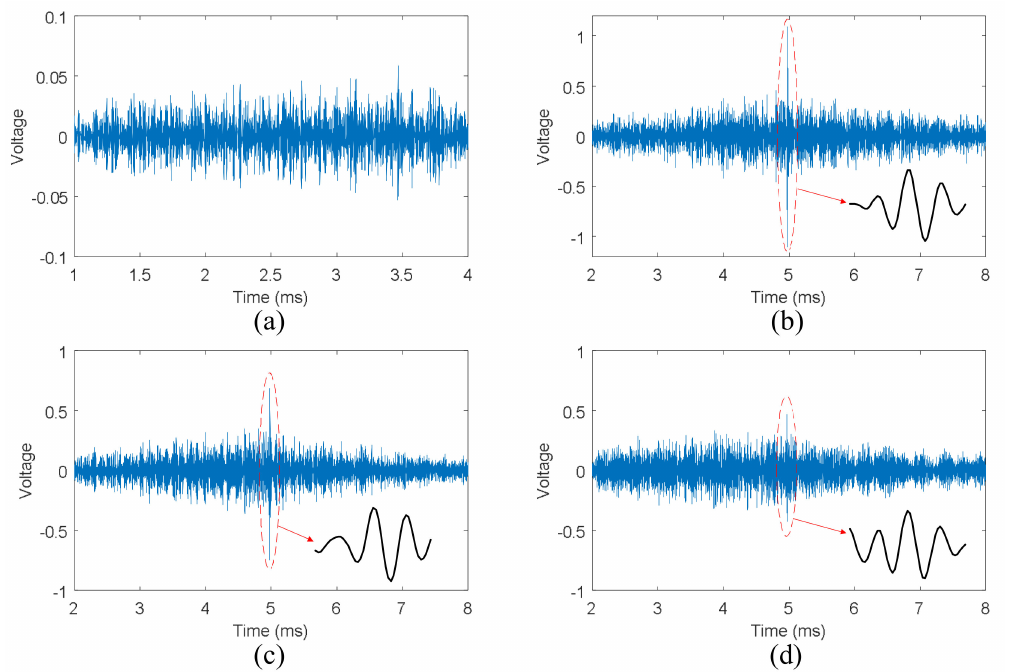
Figure 7. Reconstructed signals using VTR method acquired from single bolt structure: ( a ) RRS signal obtained in the healthy state; ( b ) reconstructed signal with 14 Nm torque; ( c ) reconstructed signal with 10 Nm torque; ( d ) reconstructed signal with 2 Nm